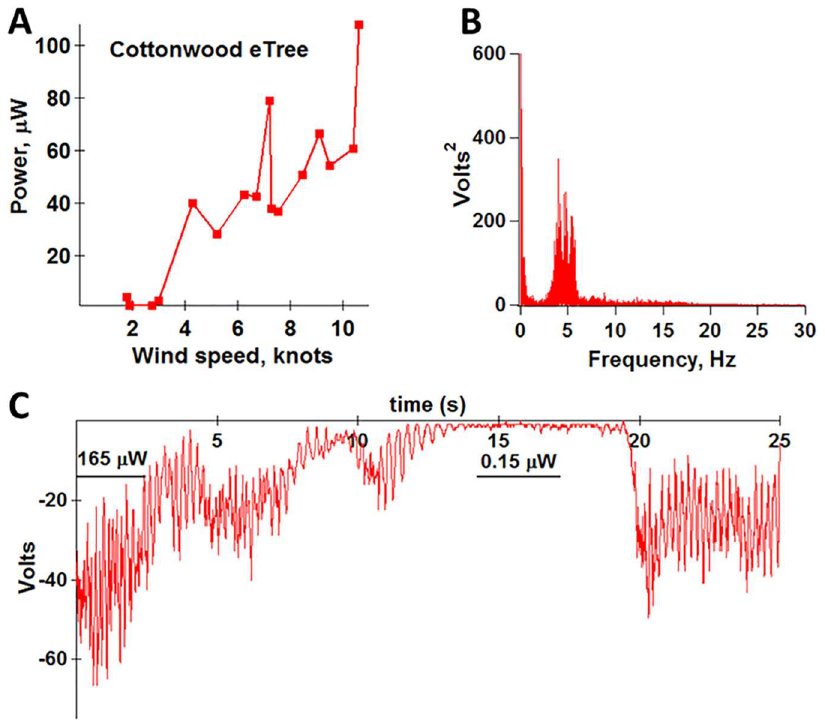
Fig 6. Power output by faux cottonwood trellis as function of wind speed. (A) Average wind speed estimated from mean of highest and lowest speedduringthe 25 s recording period.At ten knots, power was ~ ten-fold that of single cottonwood mimic indoors. (B) Power spectrum of single leaf during500 s, in wind fluctuatingfrom 7.5 to 9 knots. (C) Primary voltage data show variation due to fluctuatingwind speedand